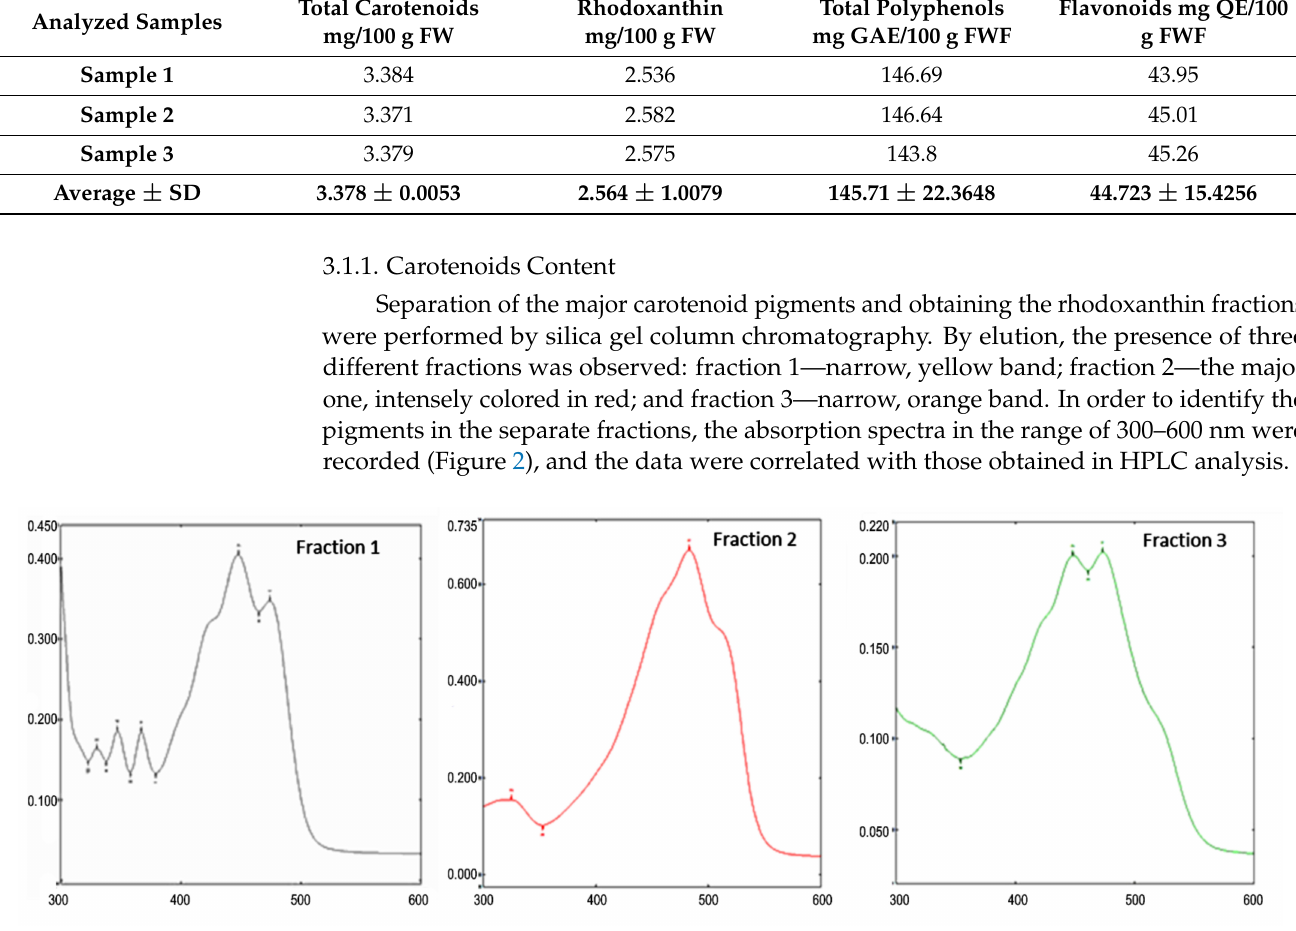
Figure 2. Absorption spectra of chromatographically separated fractions from aril extracts of Taxus baccata